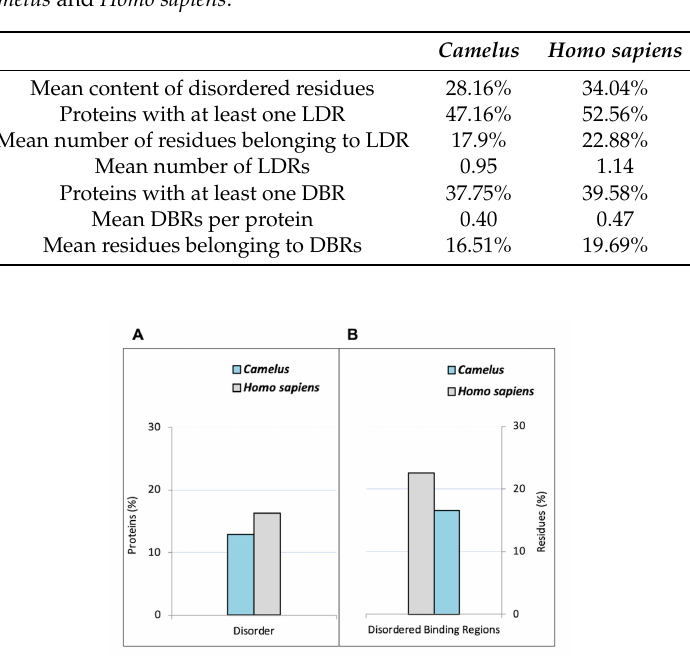
Figure 1. Overall predicted disorder and disorder binding regions (DBRs) in Camelus and Homo sapiens . ( A ) Percentage of proteins with at least one long disordered region (LDR) with at least 50% disordered residues (according to DISOPRED predictions). ( B ) Percentage of disordered residues involved in binding (according to ANCHOR predictions).